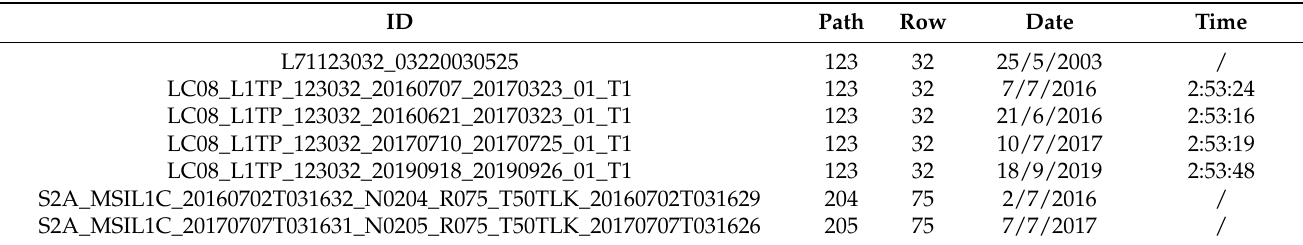
Table 1. Landsat and Sentinel image IDs. Timing is referenced to the Greenwich Mean Time (GMT).